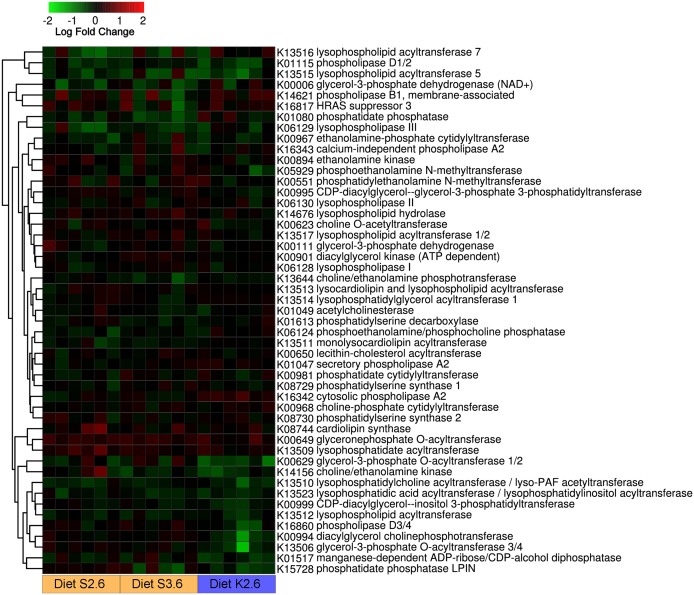
Genes participating to the glycerophospholipid metabolism (Kegg ID ko00564).Values represent expression in the intestine of 2.5 g fish fed diet S2.6, S3.6 and K2.6. Expression values are reported for each individual replicate compared to average of 1.5g fish fed the basal unsupplemented diet (1.5% phospholipid content). Kegg identifiers (Kxxxxx) are specified for each gene. Data were plotted using heatmap.2 [37] and rows were clustered according to Euclidean distance.